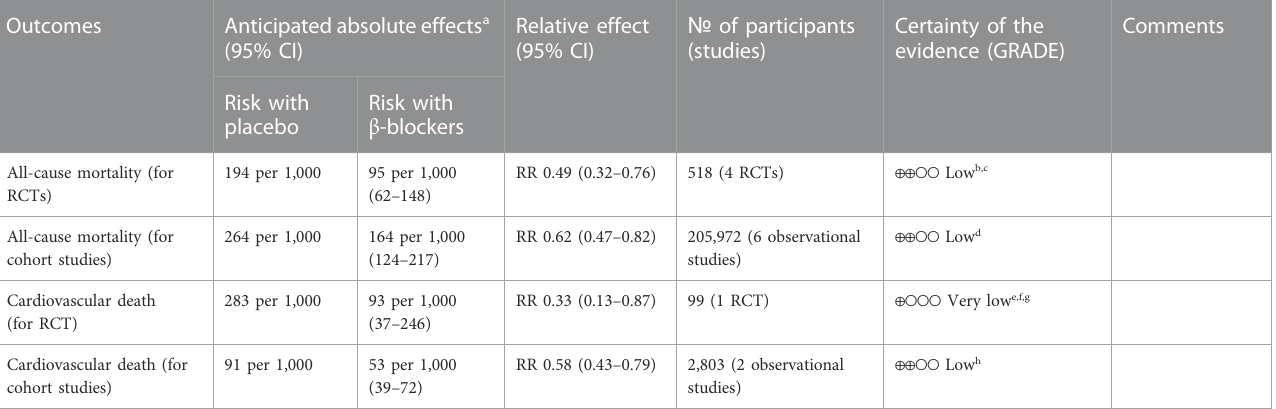
TABLE 4 GRADE quality of evidence summary